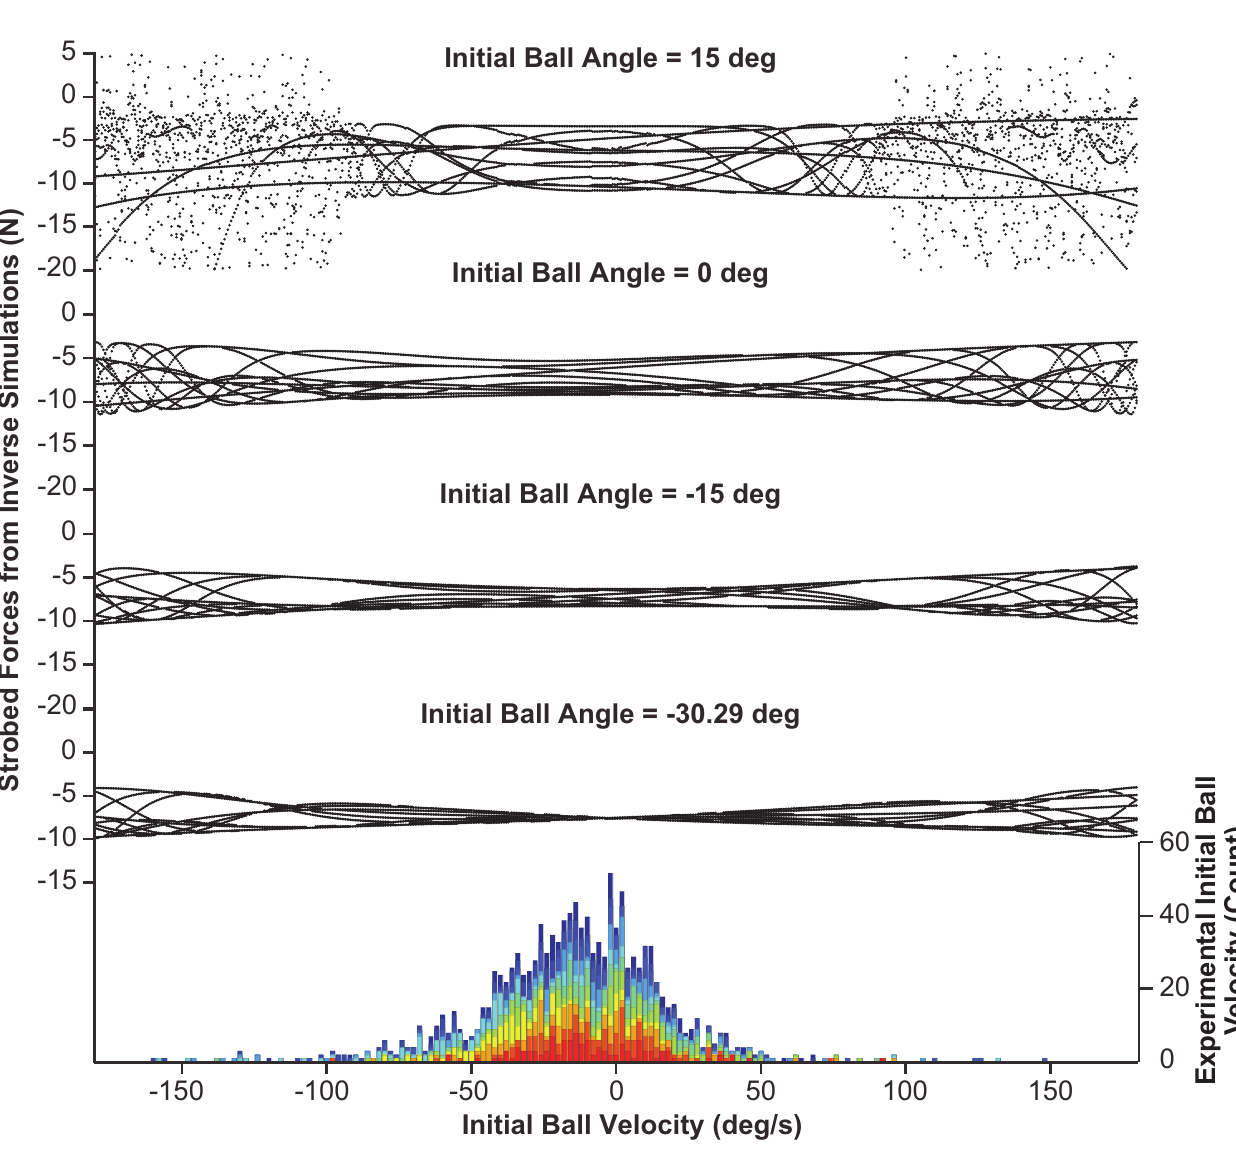
Fig 12. Effect of initial ball velocity on interaction forces: Stroboscopic plots of F inter ( t ) across different initial ball velocities, _ y _ different initial ball angles, θ 0 ; from top to bottom: +15 deg, 0 deg, -15 deg and -30.29 deg. These distributions were obtained for each simulation with different _ y _ from -180 deg/s to +180 deg/s (step size 5 deg/s). The bottom panel includes the histogram of _ y _ 0 subjects appear in different